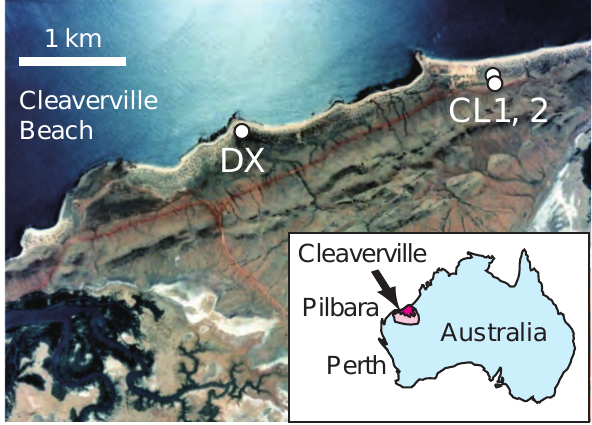
Figure 1. Aerial photo showing locations of drilling sites CL1, CL2, and DX for DXCL-DP in Cleaverville, northwestern coast of Pilbara district, Western Australia. Coordinates of the DX site are 20°39'21"S and 117º00'04"E. Aerial photo is taken from “Google Earth” (http://